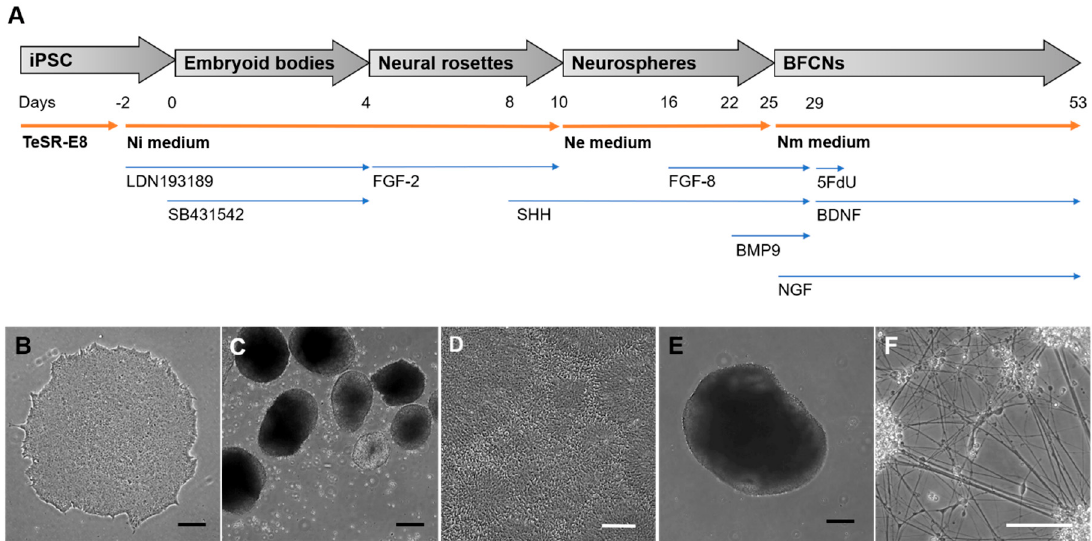
Figure 1. Differentiation of BFCNs from iPSCs . The iPSCs were differentiated into BFCNs by the combination of small molecule inhibitors and specific growth factors mimicking the developmental signals. ( A ) Schematic diagram showing the different stages of the differentiation in grey arrows over time. Orange arrows showing the cell culture media used in each stage and blue arrows showing the small molecule inhibitors or growth factors used at each specific time points. ( B–F ) Representative phase contrast pictures of the last day at each stage: ( B ) iPSC, ( C ) embryoid bodies, ( D ) neural rosettes, ( E ) neurospheres and ( F ) BFCNs. Black scale bars = 200 μ m and white scale bars = 100 μ m.